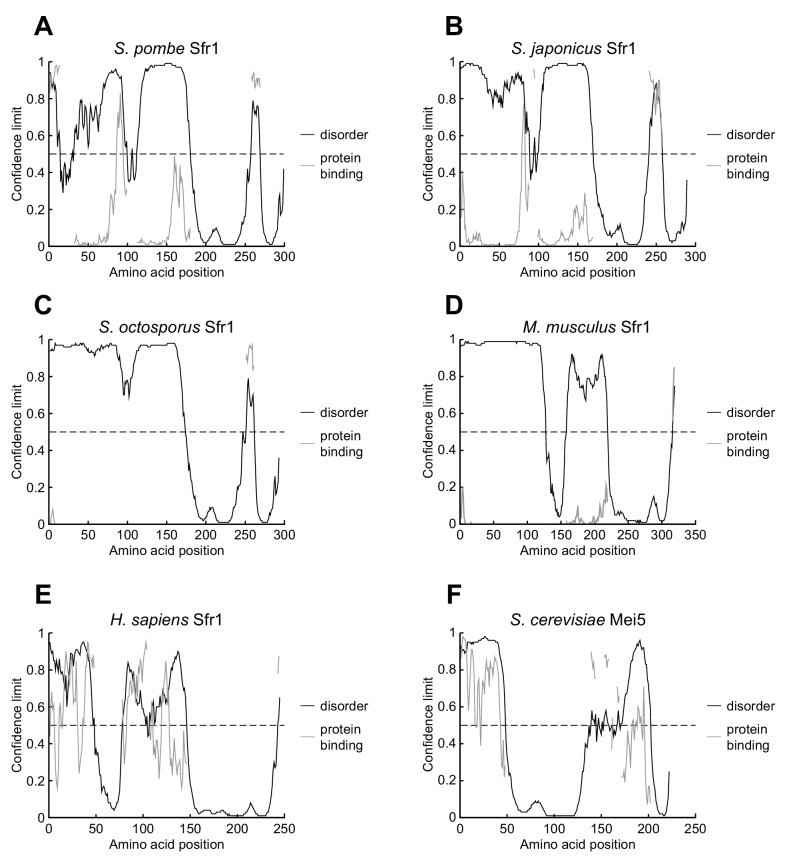
N-terminal intrinsically disordered domains may be an evolutionarily conserved feature of Sfr1.(A–F) DISOPRED3 was used to predict the likelihood of disorder and protein binding in orthologs of Sfr1 from the indicated species. The likelihood of disorder is shown on the y-axis and residues of Sfr1 are displayed on the x-axis. The dashed line represents a confidence limit of 0.5, above which point DISOPRED3 predicts that a residue is more likely to be disordered than structured. Sequences were obtained from UniProt (S. pombe, Q9USV1; S. japonicus, B6JYP3; S. octosporus, S9R1E2; Mus musculus, Q8BP27; Homo sapiens, Q86XK3; S. cerevisiae, P32489).